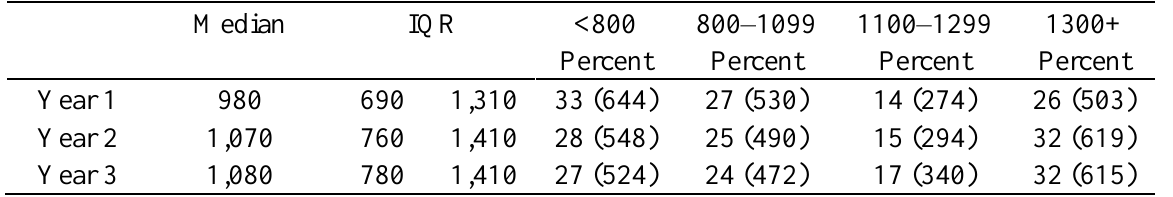
Table 1. Estimated calcium intake (mg/day) and proportion of women in each category of intake.